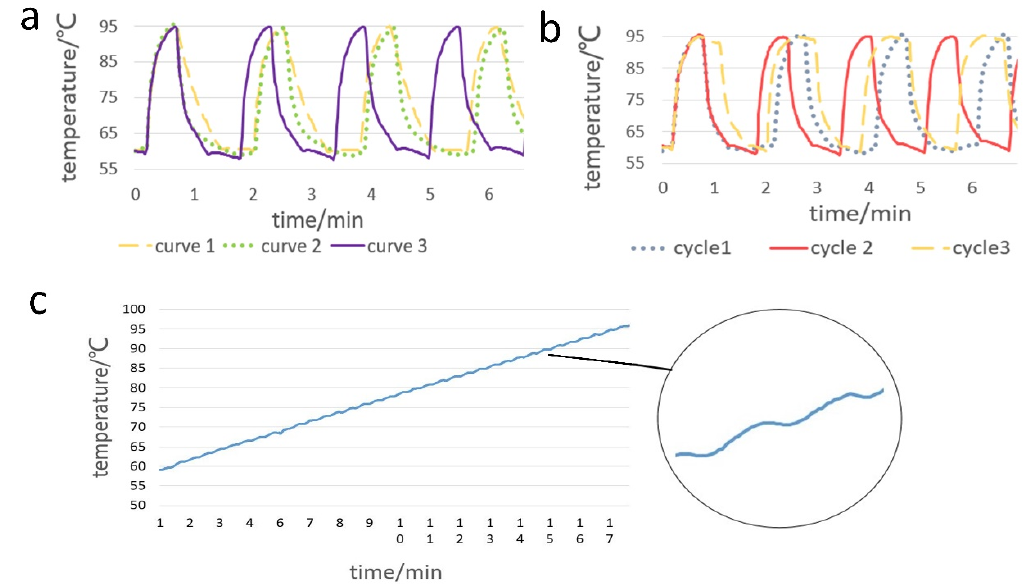
Figure 4. ( a ) Curve 1 is the temperature curve when the chip is cooled to about 60 °C in air. Curve 2 corresponds to the curve when the chip is cooled directly by a 60 °C heat source. Curve 3 corresponds to first cooling with a heat source at 60 °C and then in air. ( b ) Temperature cycling for different holding times at 95 °C and at 60 °C. ( c ) Melting curve temperature profile when the temperature gradually increases from 60 °C to 95 °C with a 1 °C interval. The enlarged circle is a partially enlarged view. Table 2. Temperature cycling characteristics of the di ff erent cooling Table 2. Temperature cycling characteristics of the different cooling modes.